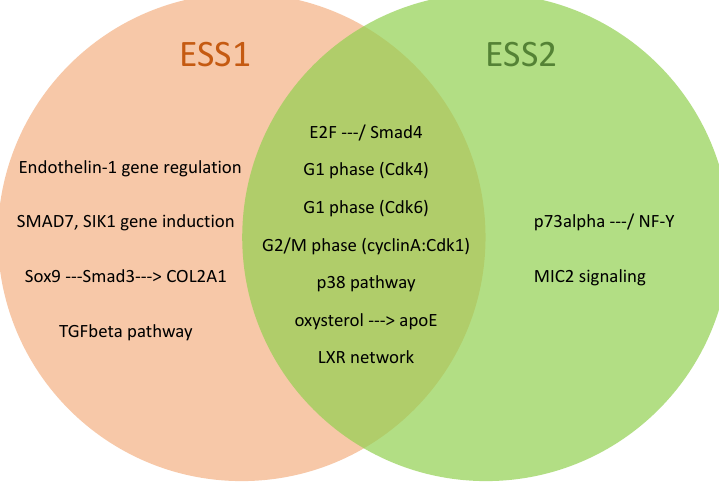
Figure 7. Venn diagram of over-represented pathways ( p adjusted < 0.001) of eggshell strength at Time Point 1 (ESS1), at Time Point 2 (ESS2), and their overlap. Pathways are based on the TRANSPATH pathway database